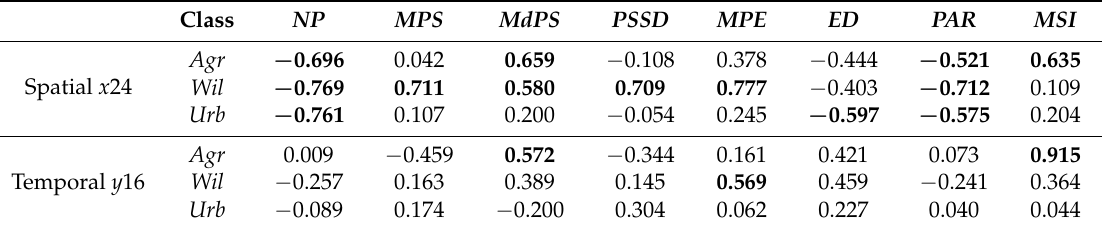
Table 4. Pearson product-moment correlation coefficient between each variable in Table 2 with the descriptors of spatial and temporal aggregation. In bold, values over